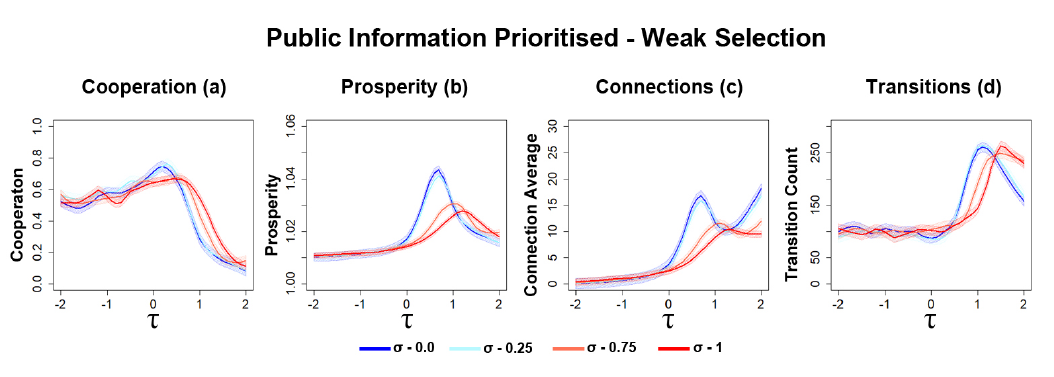
Figure 12. Prioritising public information leads to a significant drop in cooperation. The plots visualise and compare the metrics of cooperation, prosperity, average connectivity and number of transitions for differing levels of opinion diversity. Data obtained by running the model for 10 8 steps with p = 0.75 and q = 0.25 and a δ setting of 0.001. τ represents the decision threshold. σ represents opinion diversity. Shading represents level of standard error calculated for each dataset. Data interpolated utilising RStudio [22]. Plots produced via RStudio utilising code found in Appendix